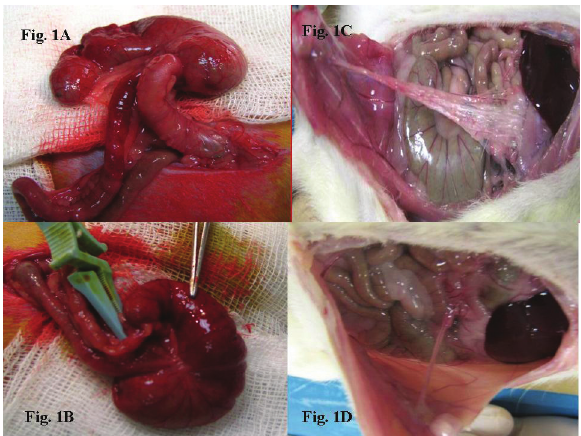
Figure 1- A-B: Scraping model. C: Grade 3 adhesion in a control group animal, with extensive and thick adhesive bands and adhesions between the organs and the abdominal wall. D: Grade 1 adhesions in Seprafilm tm group and honey group animals with thin, easily removable adhesive bands between the organs and the abdominal